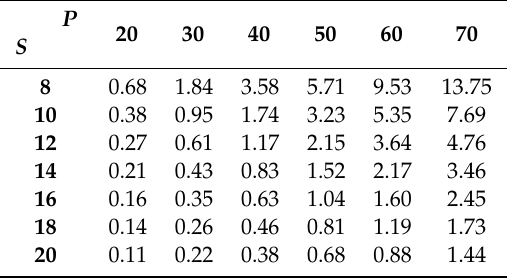
Table 4. The average execution time ( / s) of the proposed method with di ff erent patch sizes ( P ) and sliding steps ( S